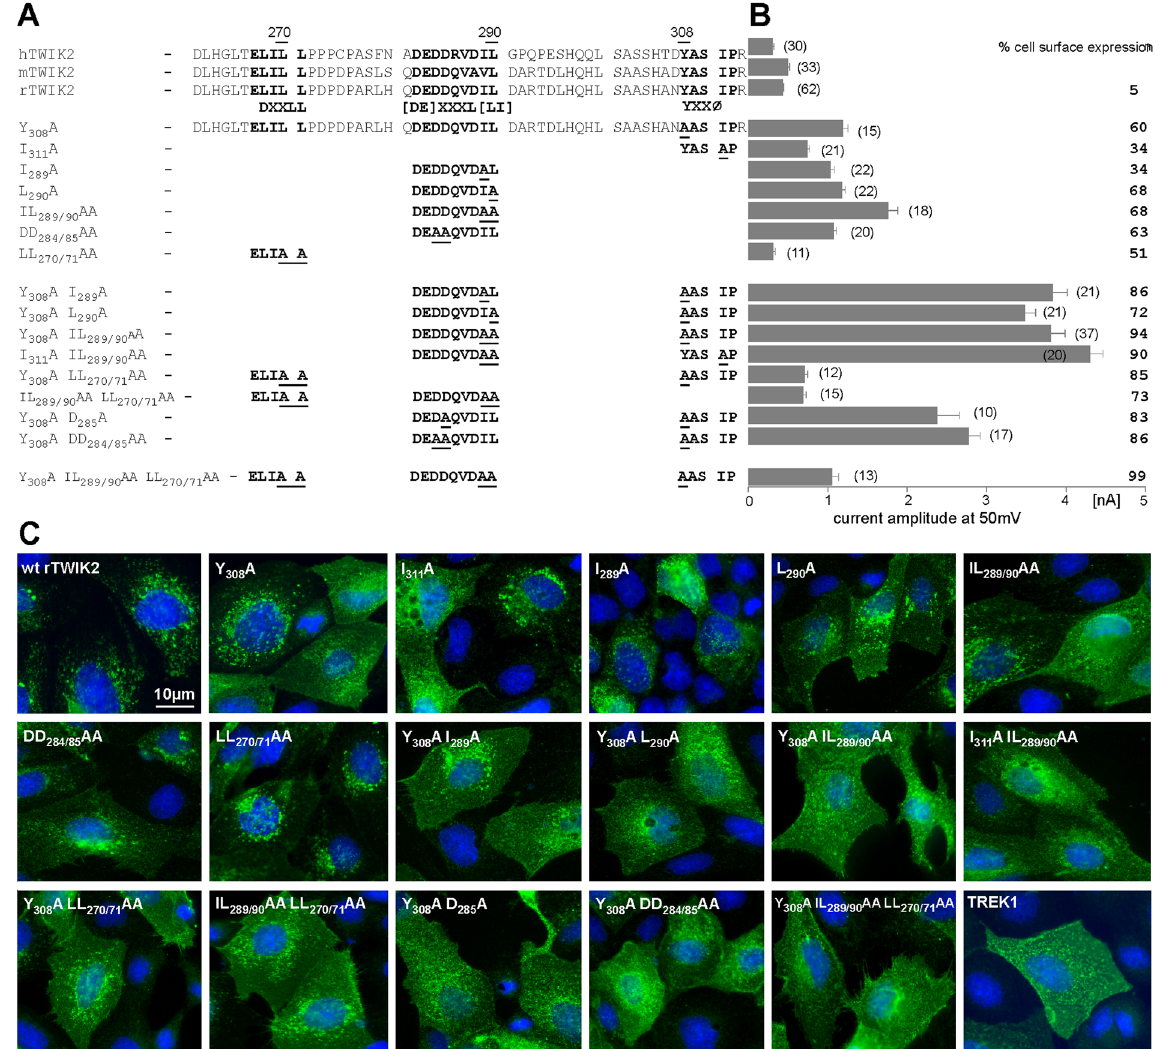
Figure 4. Identification of trafficking motifs in the C-ter of TWIK2. ( A ) Sequence of human, rat and mouse TWIK2 C-ter. The trafficking motifs are shown in bold. Overview of the set of generated mutants, in which underlined amino acids were replaced by an alanine residue. ( B ) Current amplitudes at + 50 mV of the corresponding rat TWIK2 mutants recorded in Xenopus oocytes (number of recorded oocytes) expressed as mean current amplitude ± sem. Mutant rat TWIK2HA channels were transfected into MDCK cells and stained with HA antibody. % cell surface expression corresponds to the percentage of transfected cells showing a clear expression of TWIK2 at the plasma membrane. ( C ) Representative images of MDCK cells expressing the different TWIK2 mutations shown in ( B ) and TREK1. Scale bar: 10 µ